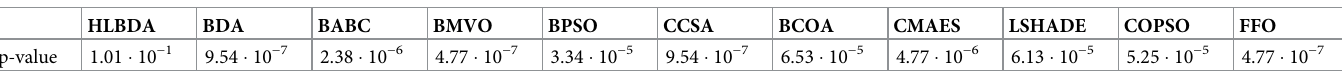
Table 13. The result of the Wilcoxon test of presented COFFO against compared methods. HLBDA BDA